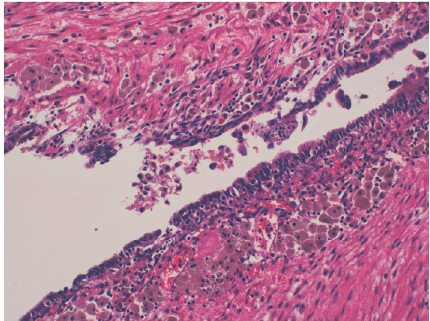
Figure 5: Pathological findings of the right ovary. Ovarian endo- metriosis of the right ovary. (H-E × 20). Ectopic endometrial tissues exist in the cyst wall, and macrophages with hemosiderin are observed.